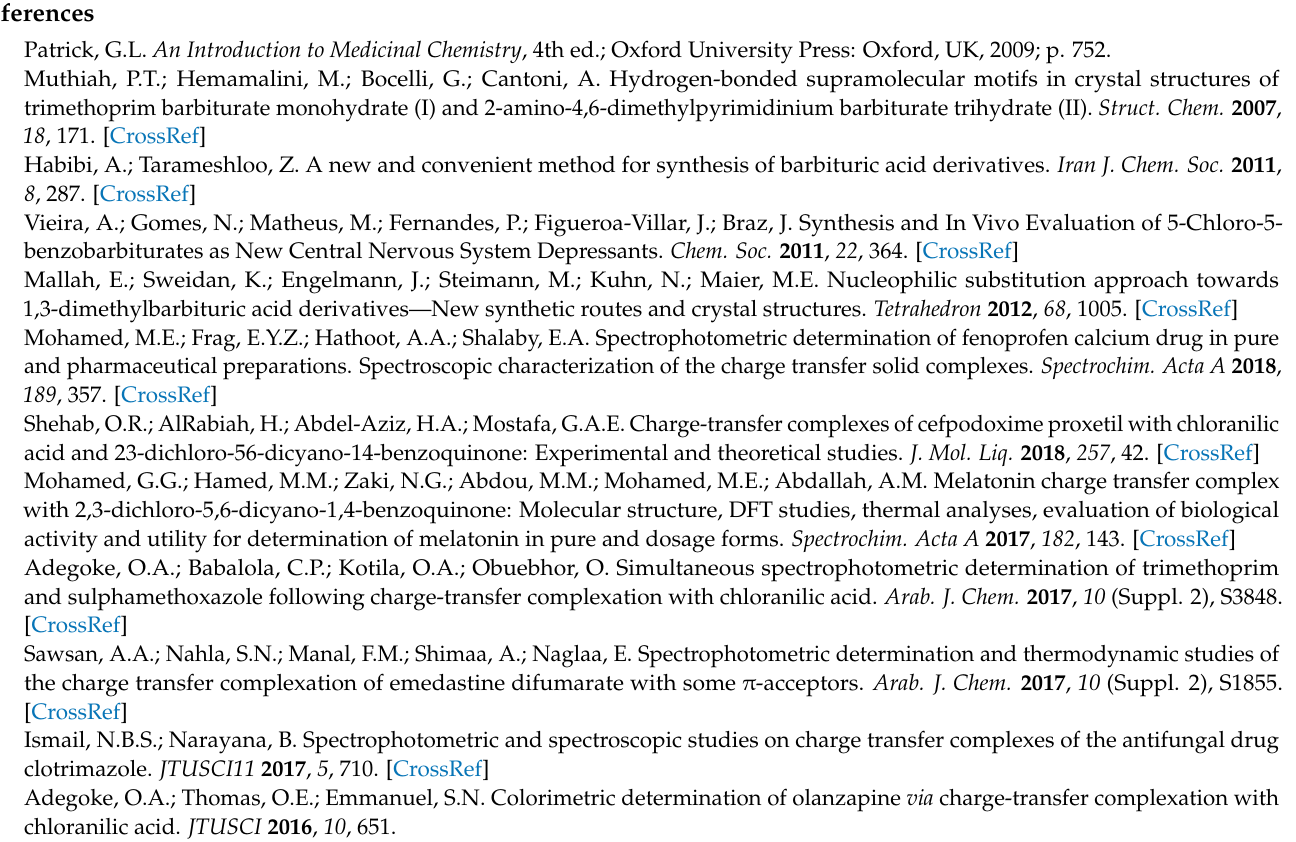
Figure S4: The docking results of (Bar)-serotonin complex. a: aromatic surface, b: hydrogen binding surface, c: hydrophobic surface, d: ionizability surface, e: solvent accessible surface, and f: Interpo- lated charge. Figure S5: Number of average hydrogen bonding interactions between (a) BarScomplex and (b) BarCS complex during 100 ns simulation time. Figure S6: Solvent accessible surface area analysis for unbound serotonin receptor (black), BarS complex (orange) and BarCS complex (green) during 100 ns simulation time. Figure S7: Optimization Steps for (Bar-CLA) (B3LYP/6-311G++). Figure S8: UV-visible spectrum of (Bar-CLA) obtained through TD-DFT calculations. Figure S9: MO energy level diagram of the CT complex (Bar-CLA). Table S1: (Bar-CLA)-dopamine interactions results by DS. Table S2: Bar-dopamine interactions results by DS. Table S3: The bond lengths of the CT complex (Bar-CLA) obtained through DFT. Table S4: The bond angles of the CT complex (Bar-CLA) obtained through DFT. Table S5: Mulliken atomic charges of the CT complex (Bar-CLA) atoms. Table S6: Theoretical molecular properties of (Bar-CLA) complex and their